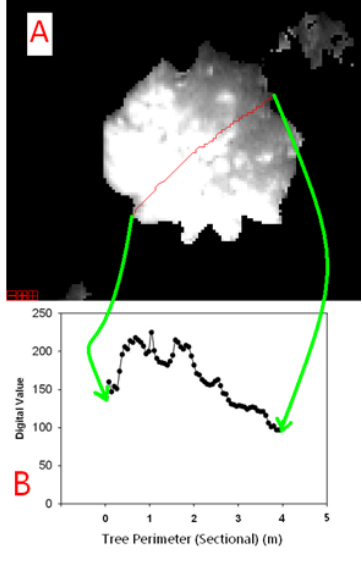
Figure 4. The illustrated procedure of obtaining longitudinal profile of a tree